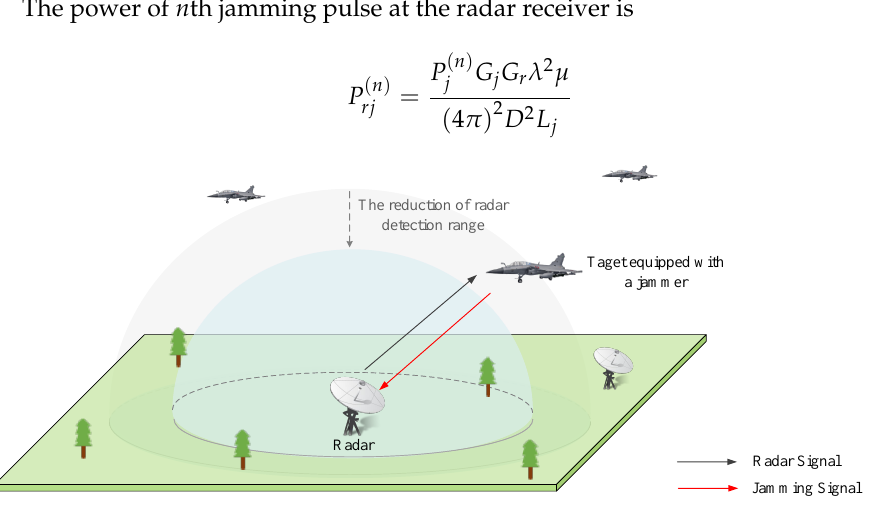
Figure 1. The self-defense electronic jamming scenario: through effective jamming, the jammer can shorten the detection range of the radar to protect the